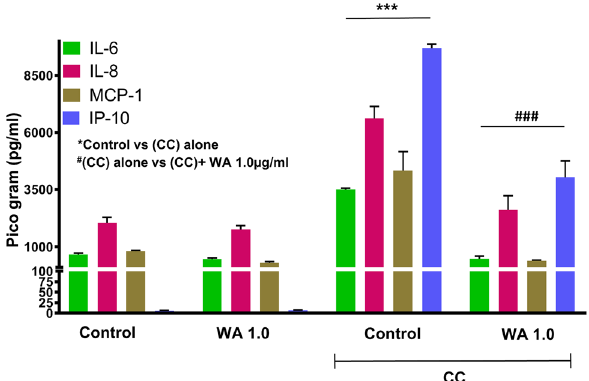
Figure 6. Ability of WA to control the release of isletokines via exosomes in cytokine-induced stressed human islets. Purified human islets of about 2500 islet equivalents (n = 3) were exposed to WA 1.0 μg/mL alone for 24 h or to a cytokine cocktail (CC) of IL-1β (100 U/mL) + IFN-γ (1000 U/mL) + TNF-α (1000 U/mL) for 24 h with or without 3 h of WA 1.0 μg/mL pretreatment. Untreated islets of approximately 2500 islet equivalents (n = 3), cultured for 24 h, were used as the control. The total amount of IL-6, IL-8, MCP-1, and IP-10 released in the culture via exosomes was quantified by ultrasensitive Luminex assay. The data show mean ± standard error of the